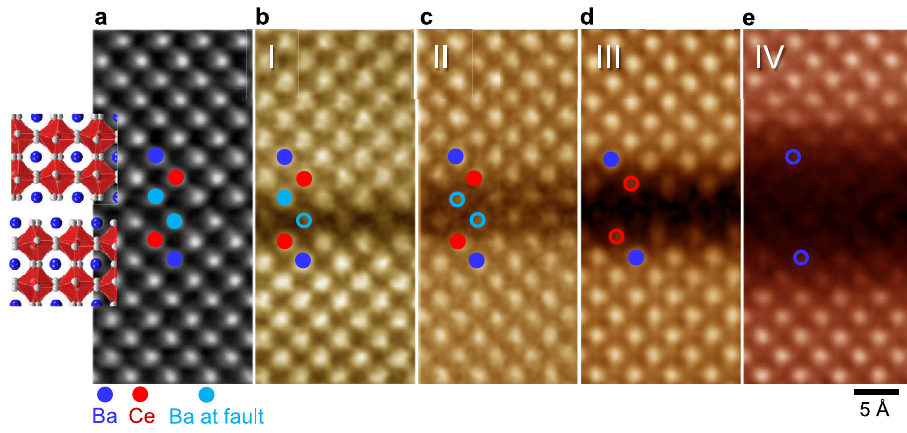
Fig. 6 | Layerwise premelting at the fault. a An atomic illustration is provided in the fi rst STEM image to verify the presence of a fault. b − d Images I − III (1400°C) directly show the layer-by-layer behavior at the initial stage of premelting. Open circles represent the layers contacting atomic columns with low intensity due to